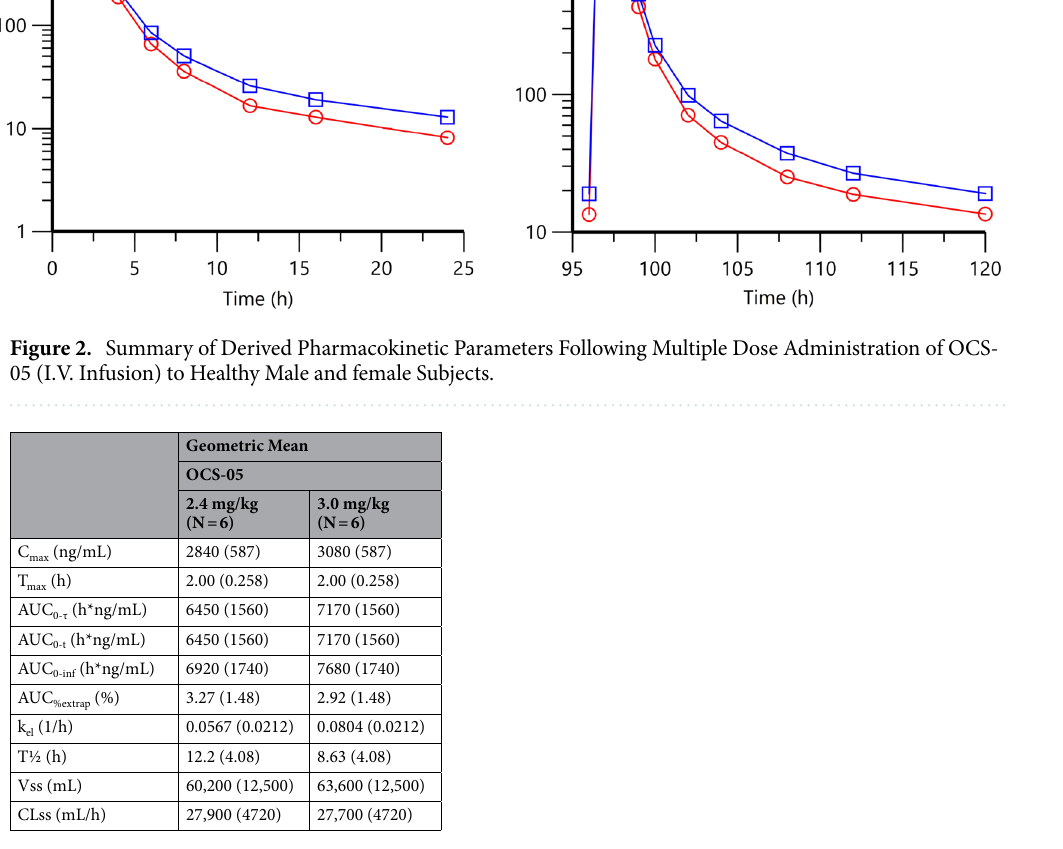
Table 5. Summary of derived pharmacokinetic parameters following multiple dose administration of OCS-05 (i.v. infusion) to healthy subjects by Day 5 as means (SD).